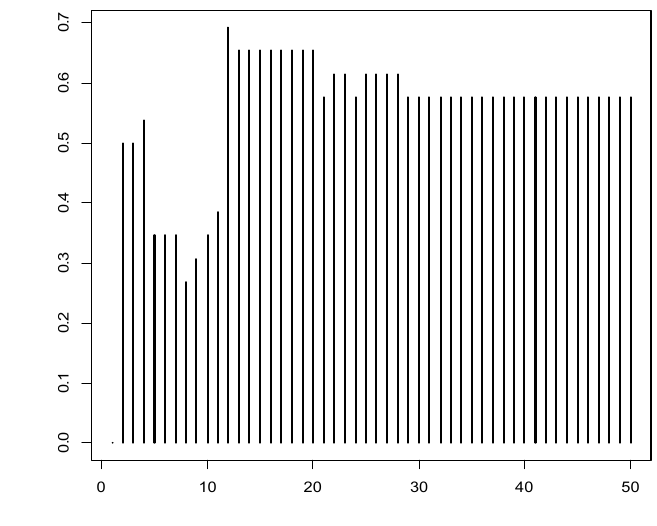
Figure 2. The proportion of cases at which the minimum value of Q was achieved.